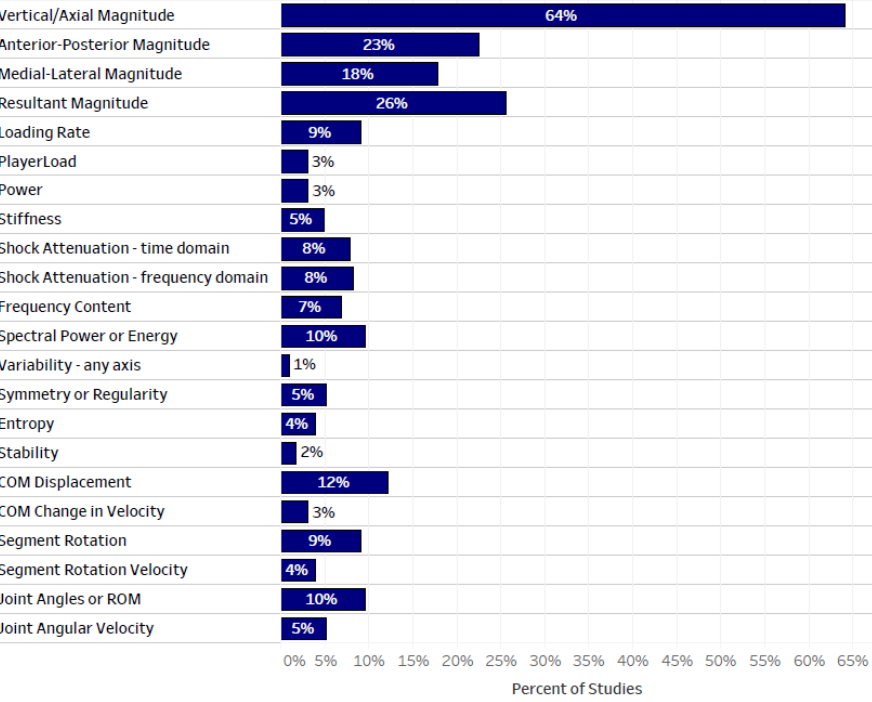
Figure 5. The percent of all studies that reported each metric. Note: studies often reported multiple metrics, and therefore the sum of all percentages is greater than 100%. COM = center of mass; ROM = range of motion.